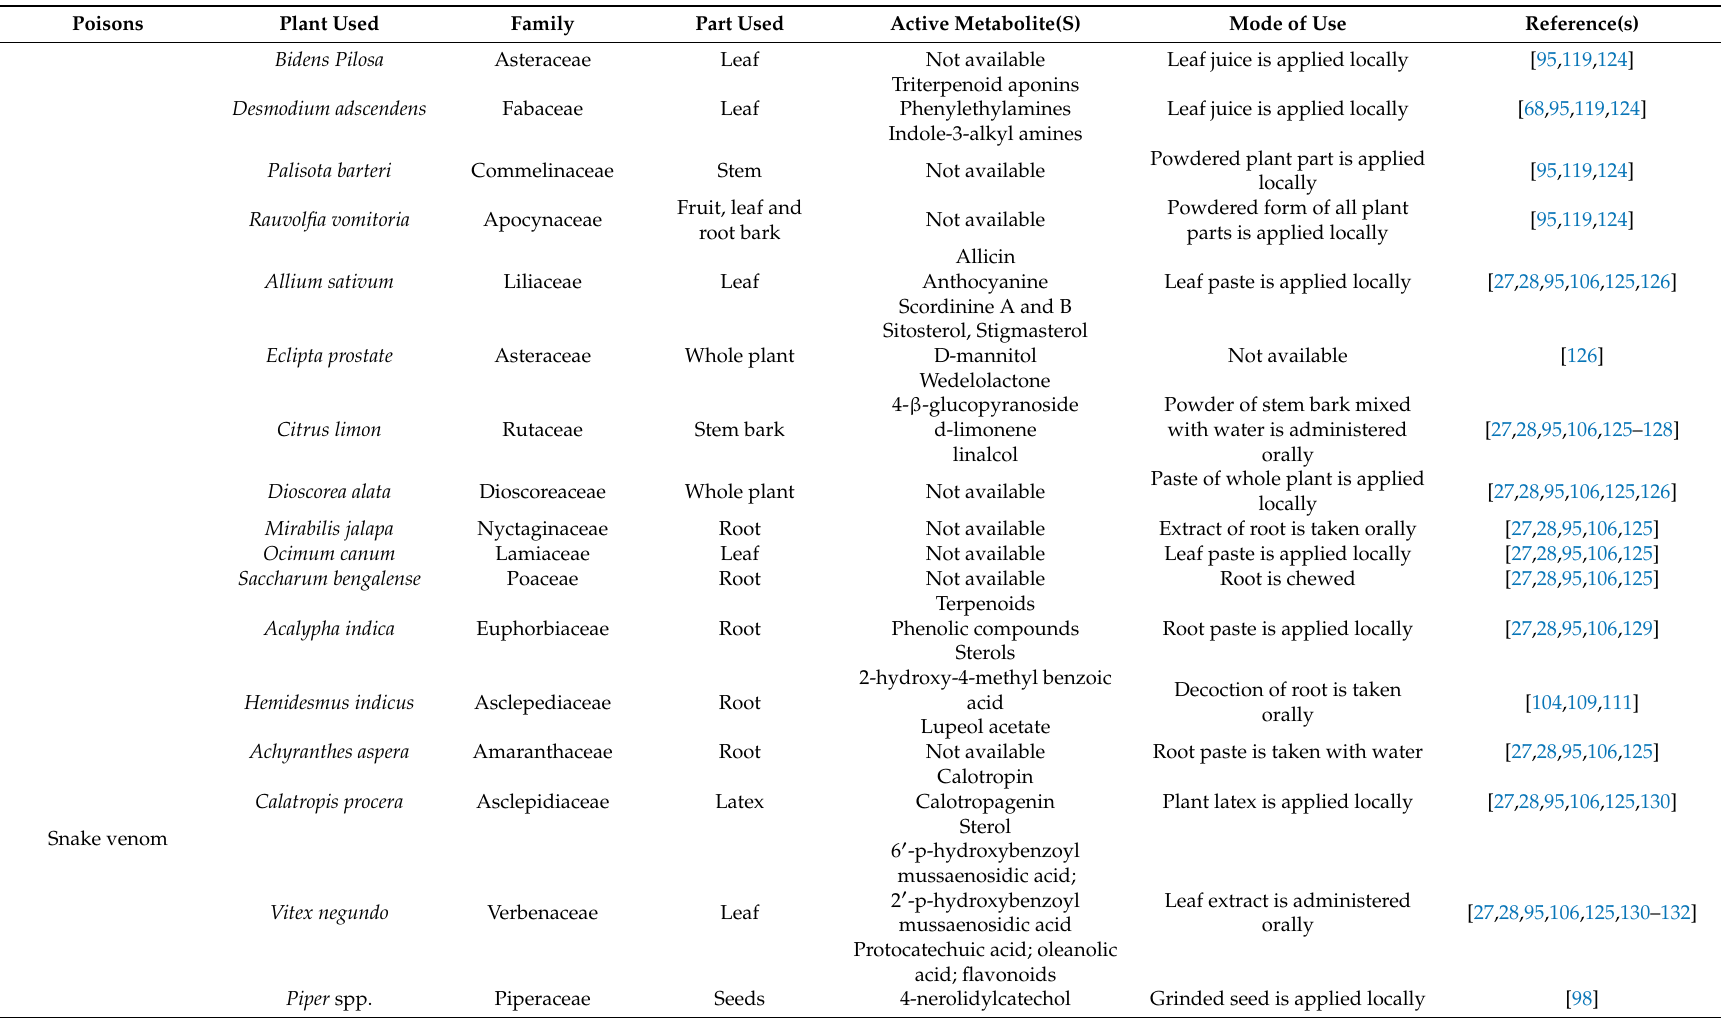
Table 3. Antidotes of plant origin and their induced e ff